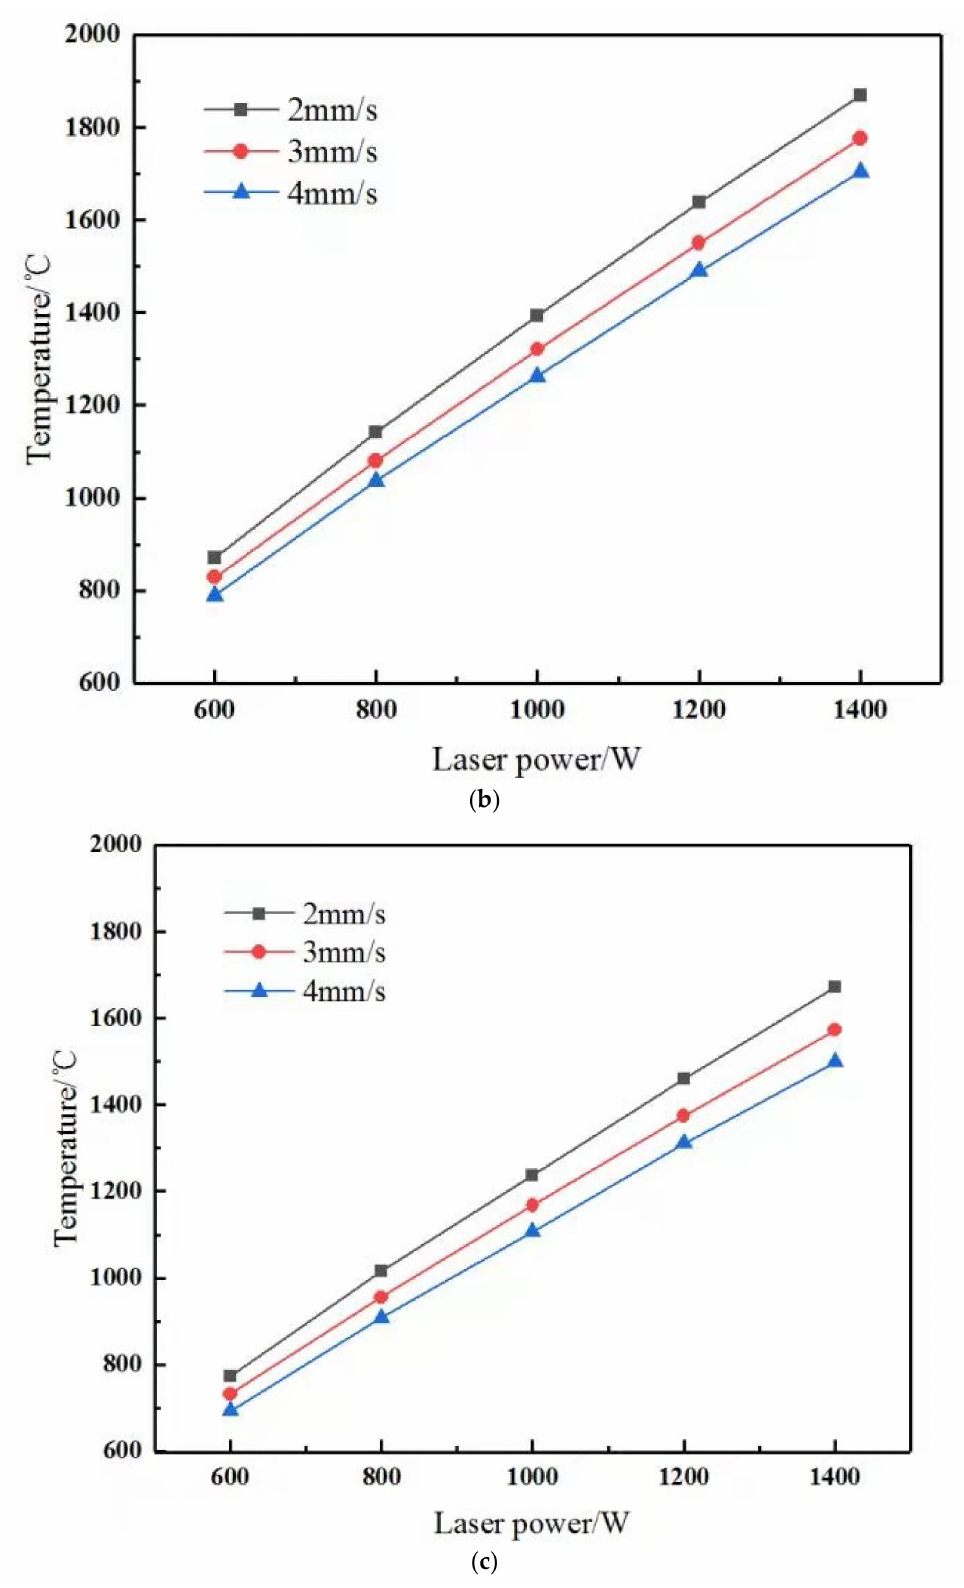
Figure 5. Maximum temperature variation with power of horizontal sample points at different scanning speed. ( a ) Sample point 10, ( b ) Sample point 6, ( c ) Sample point